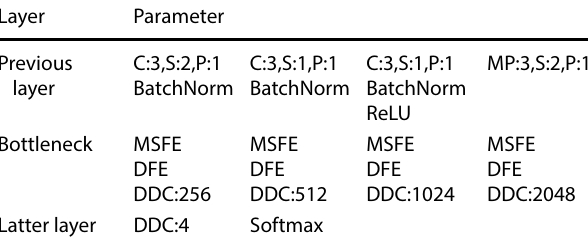
Table 1 Network structure and parameter setting Layer